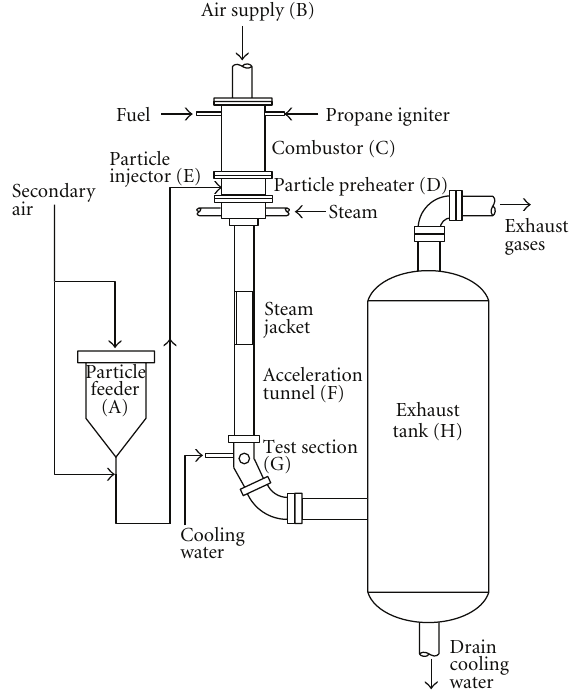
Figure 1: Schematic of erosion test facility.